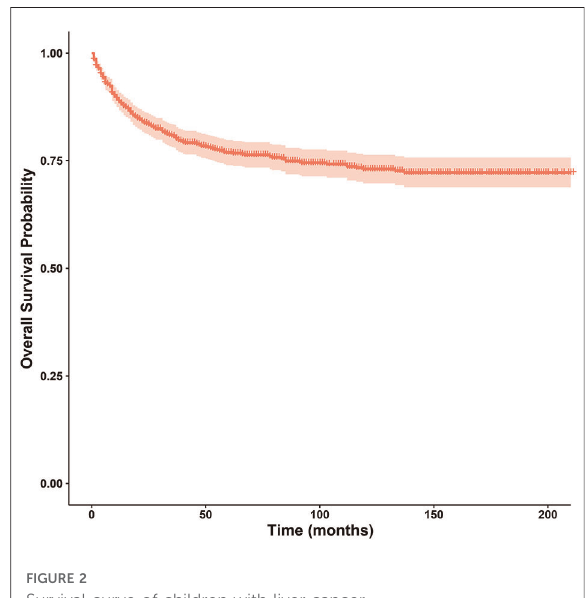
FIGURE 2 Survival curve of children with liver